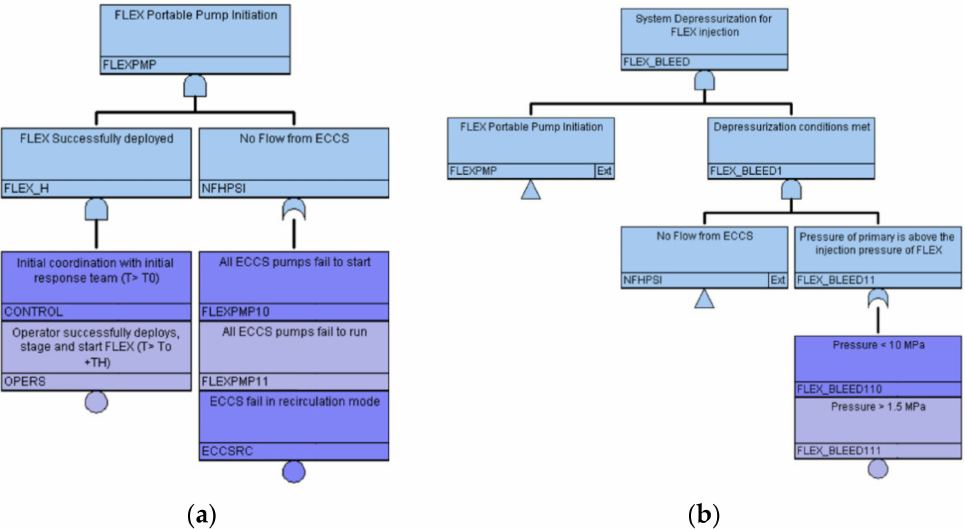
Figure 5. Trip logic implemented in the RELAP5 input model for: ( a ) coolant injection using portable FLEX pumps; ( b ) primary depressurization using pressurizer relief